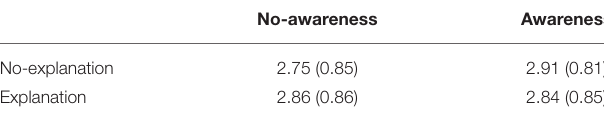
TABLE 5 | Means and standard deviations (in brackets) of psychological reactance for each of the experimental conditions.